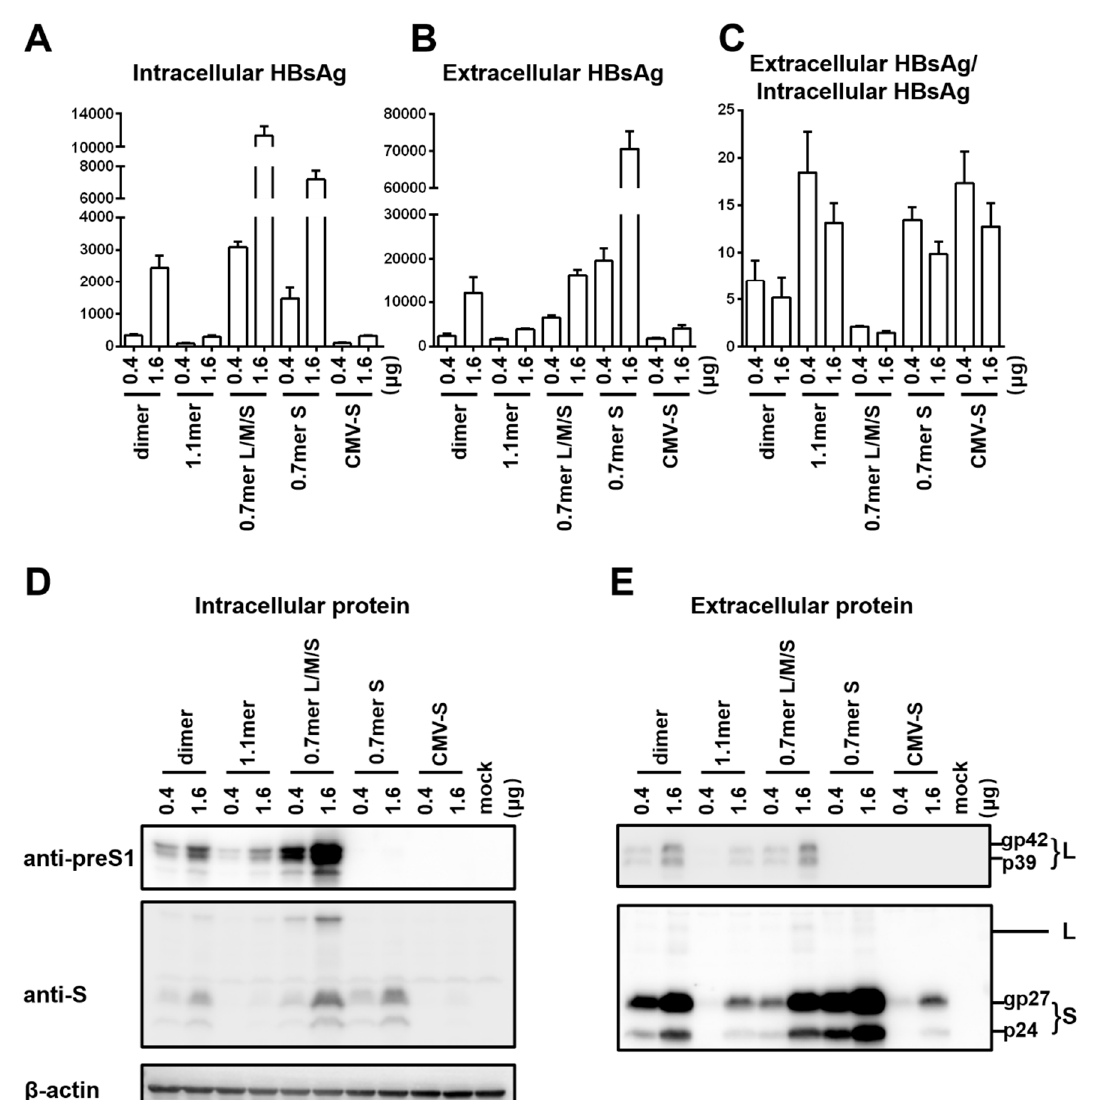
Figure 3. Comparison of five types of replication or expression constructs for efficiency of envelope protein expression and HBsAg secretion: the genotype A clone. Huh7 cells in 6-well plates were transfected with 0.4 or 1.6 μ g of various HBV DNA constructs of geno5.4 (genotype A). Cells and culture supernatant were harvested four days later. ( A , B ) Total amount of HBsAg (OD 450 ) from cell lysate ( A ) and culture supernatant ( B ). Data were averaged from three independent transfection experiments. ( C ) The calculated ratio of extracellular/intracellular HBsAg. ( D , E ) Western blot analysis of intracellular ( D ) and extracellular ( E ) L and S proteins from same volume of cell lysate or culture supernatant by anti-preS1 and anti-HBs antibodies, respectively. β -actin was used as an intracellular loading control.